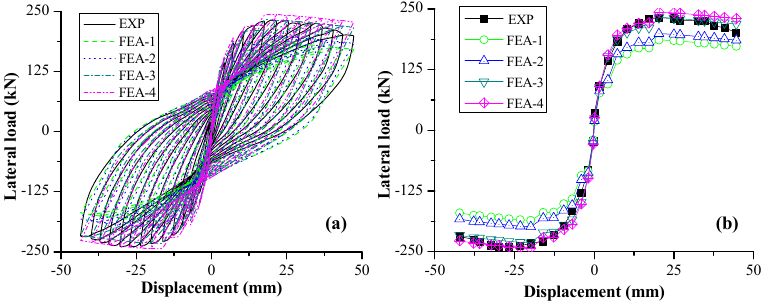
Figure 8. Hysteretic responses of the specimens: ( a ) hysteretic loops; and ( b ) envelop curves.